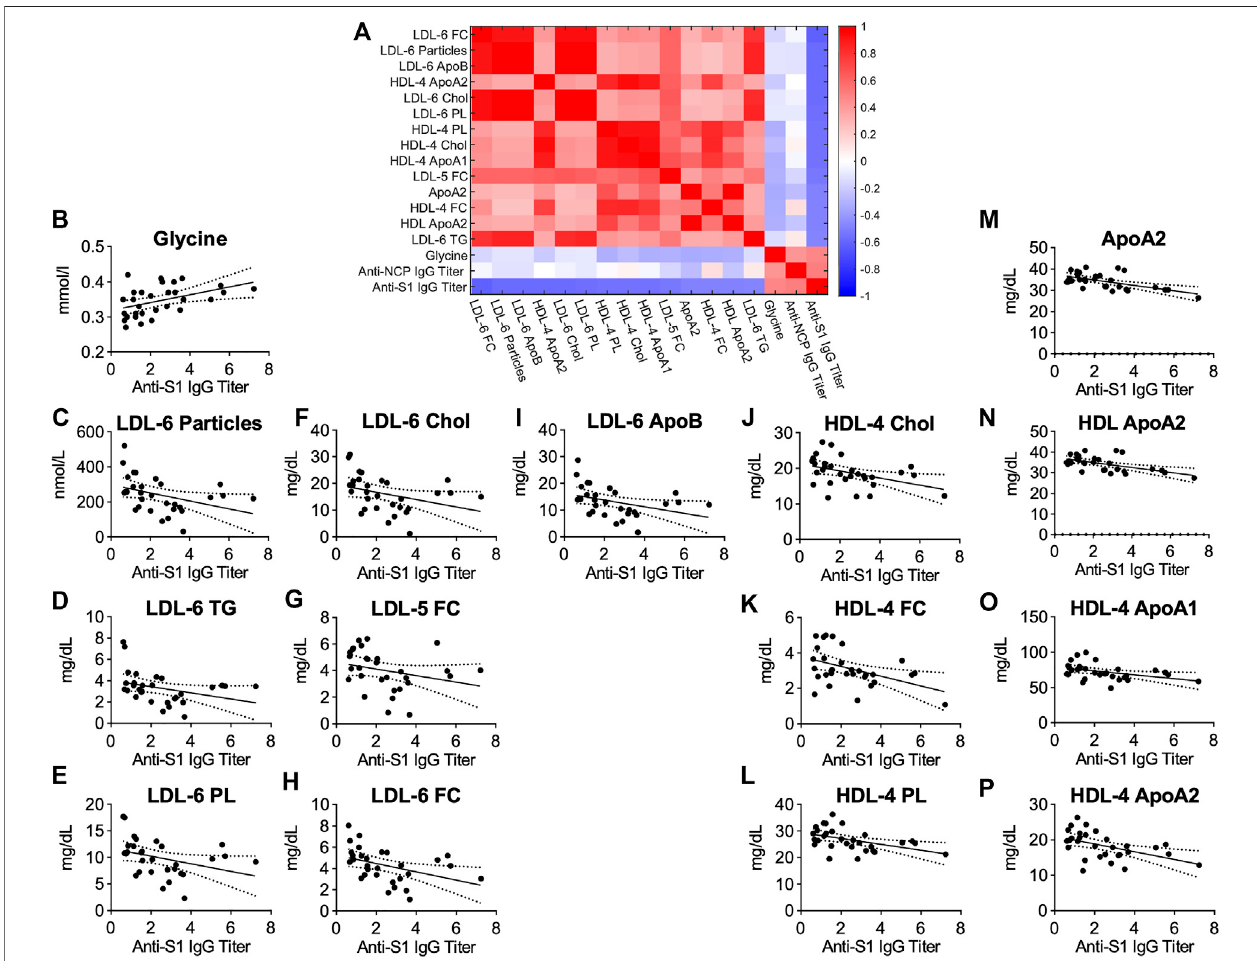
FIGURE 6 | (A ) Heatmapcorrelatingmetaboliteandlipoproteinlevelsagainstanti-S1-IgGtiterforindividualswhotestedpositiveforanti-SARS-CoV-2antibodies(anti- S1-IgG+). (B – P) Spearman correlation plots for most signi fi cant individual metabolites or lipoproteins against anti-S1-IgG titer ( p -values in Supplementary Table S2 ).